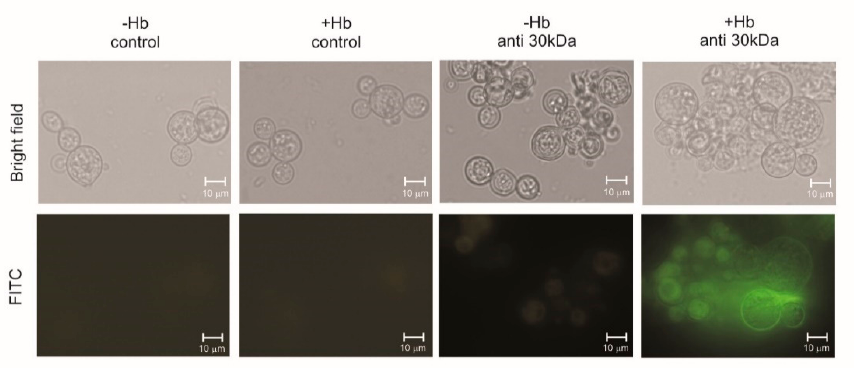
Figure 3. Analysis of hemoglobin influence on HSP30 protein expression at the cell surface of P. lutzii . Yeast cells were grown in the presence or absence of hemoglobin. Methanol fixed, non- permeabilized cells were incubated with anti-HSP30 antibodies or with pre immune serum for control. The pictures were taken in bright field and at 450/490 nm of fluorescein isothiocyanate (FITC) probe. All representative pictures were taken using an Axioscope microscope (Carl Zeiss AG, Berlin, Germany) and magnified 400 ×